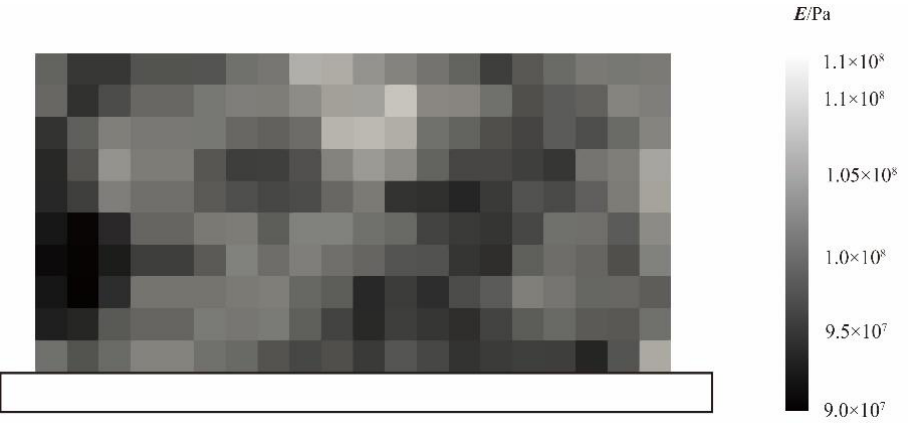
Figure 6 . One realisation of the random field of Young’s modulus. Figure 6. One realisation of the random field of Young’s